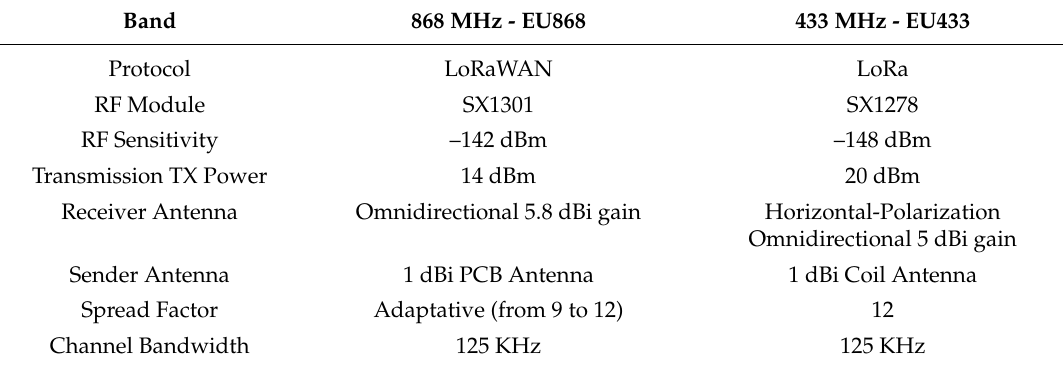
Table 8. Main characteristics of the LoRa/LoRaWAN gateways of the